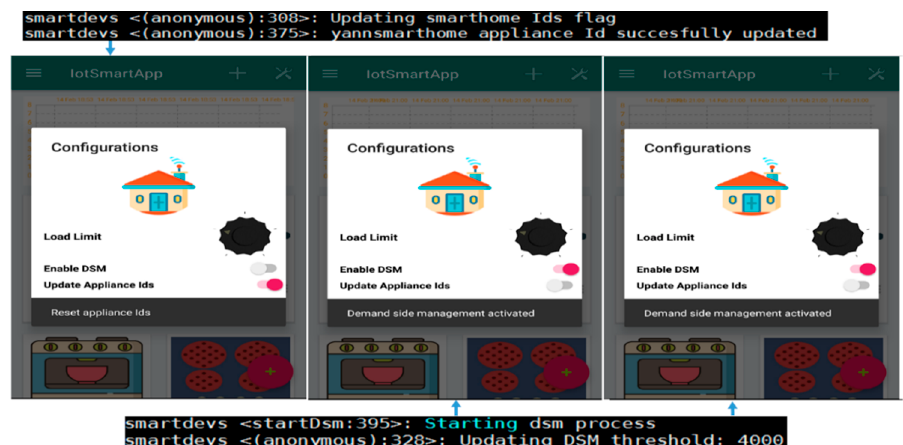
Figure 14. DRM with energy app .